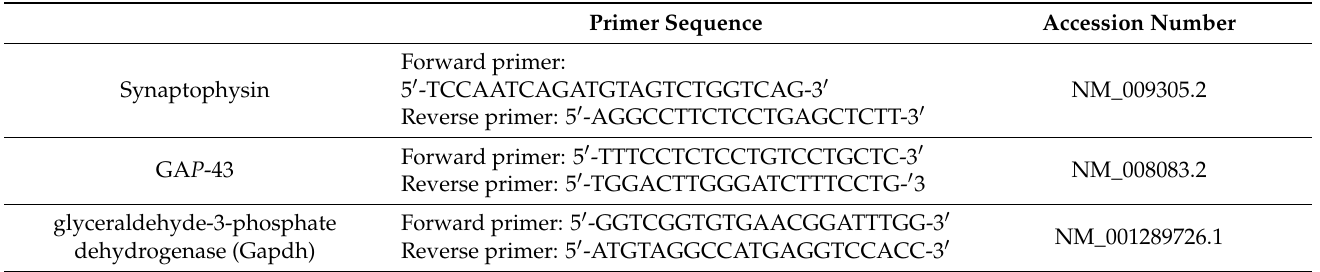
Table 1. The primer sequence of the studied genes. Primer